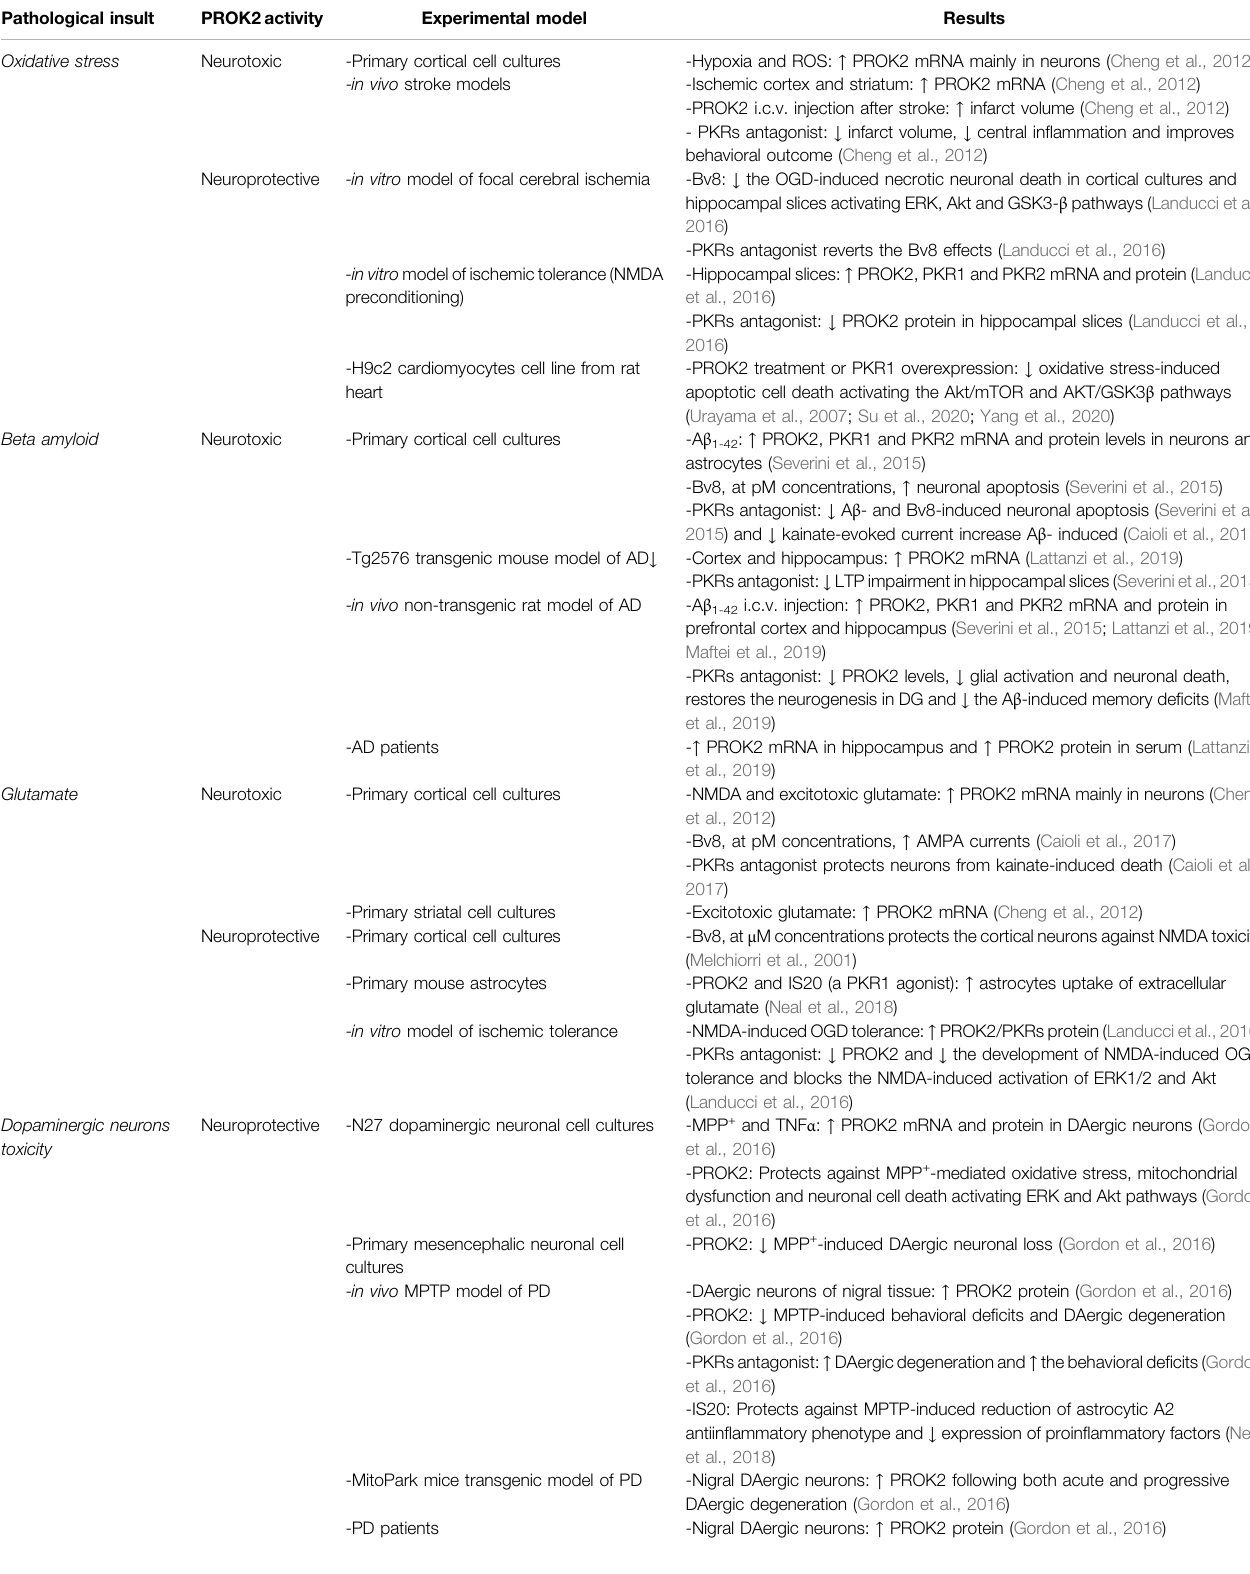
TABLE 1 | PK system modulation related to neurotoxic or neuroprotective activity following different pathological insults. Pathological